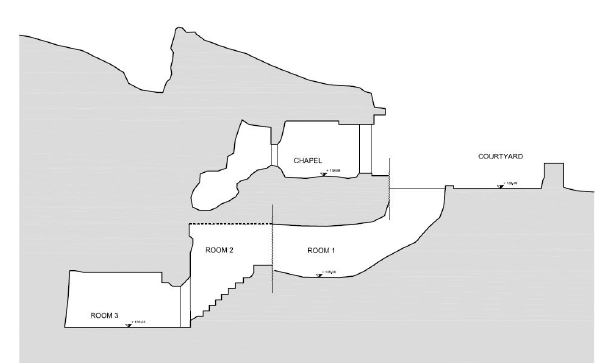
Figure 6. Seamless 3D mesh optimised in Geomagic Design X, bottom view.